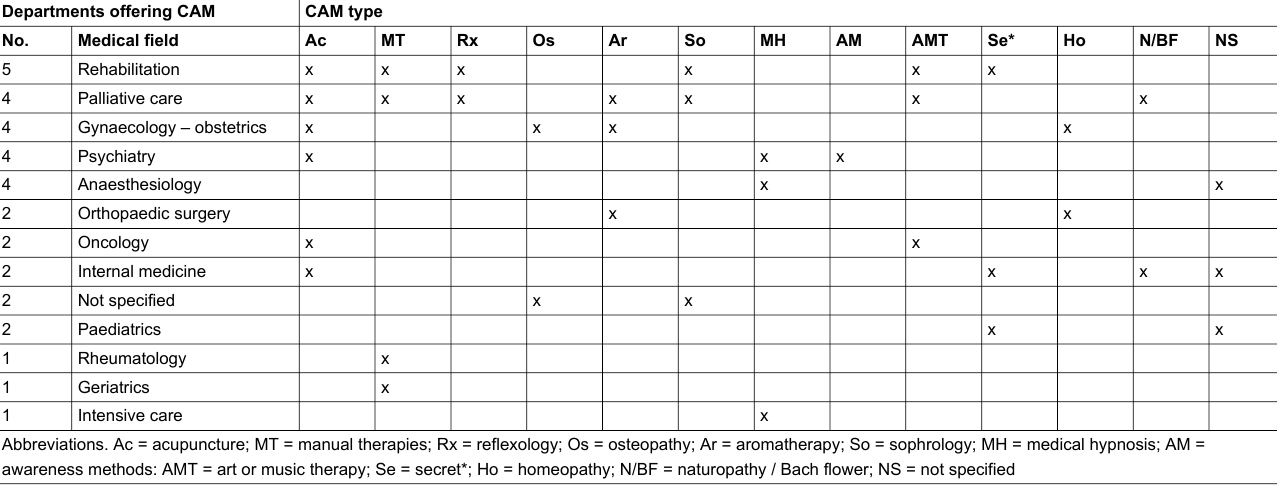
Table 1: Medical departments offering CAM (hospitals and clinics in the French-speaking part of Switzerland). Departments offering